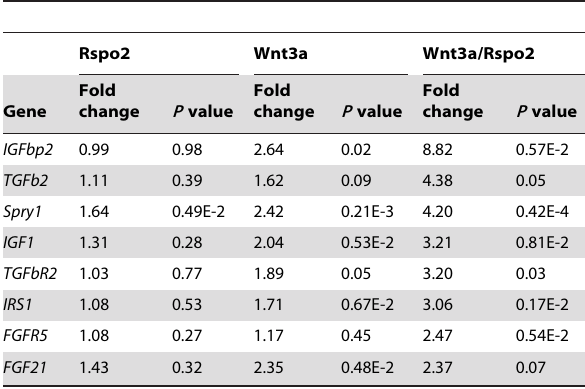
Table 5. Microarray data of additional novel target genes validated by